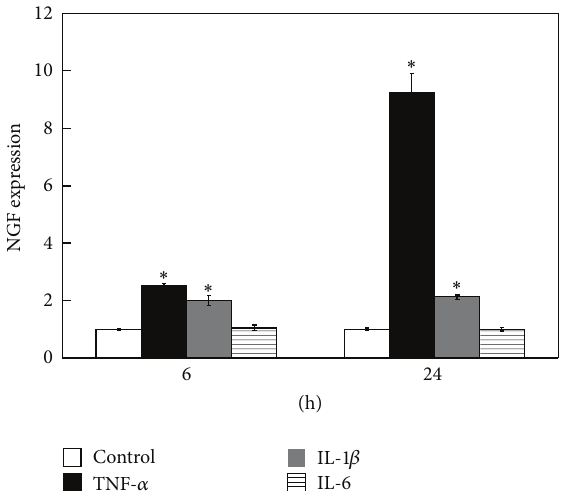
Figure 3: Effect of inflammatory cytokines on NGF gene expression in cultured synovial cells. Effect of TNF- 𝛼 , IL-1 𝛽 , and IL-6 on NGF gene expression in cultured synovial cells obtained from STR/Ort mice. All real-time PCR data are presented as the mean ± SE of four experiments. Cells stimulated with cytokines were compared with untreated cells as a control. ∗ 𝑝 < 0.05 versus control group.